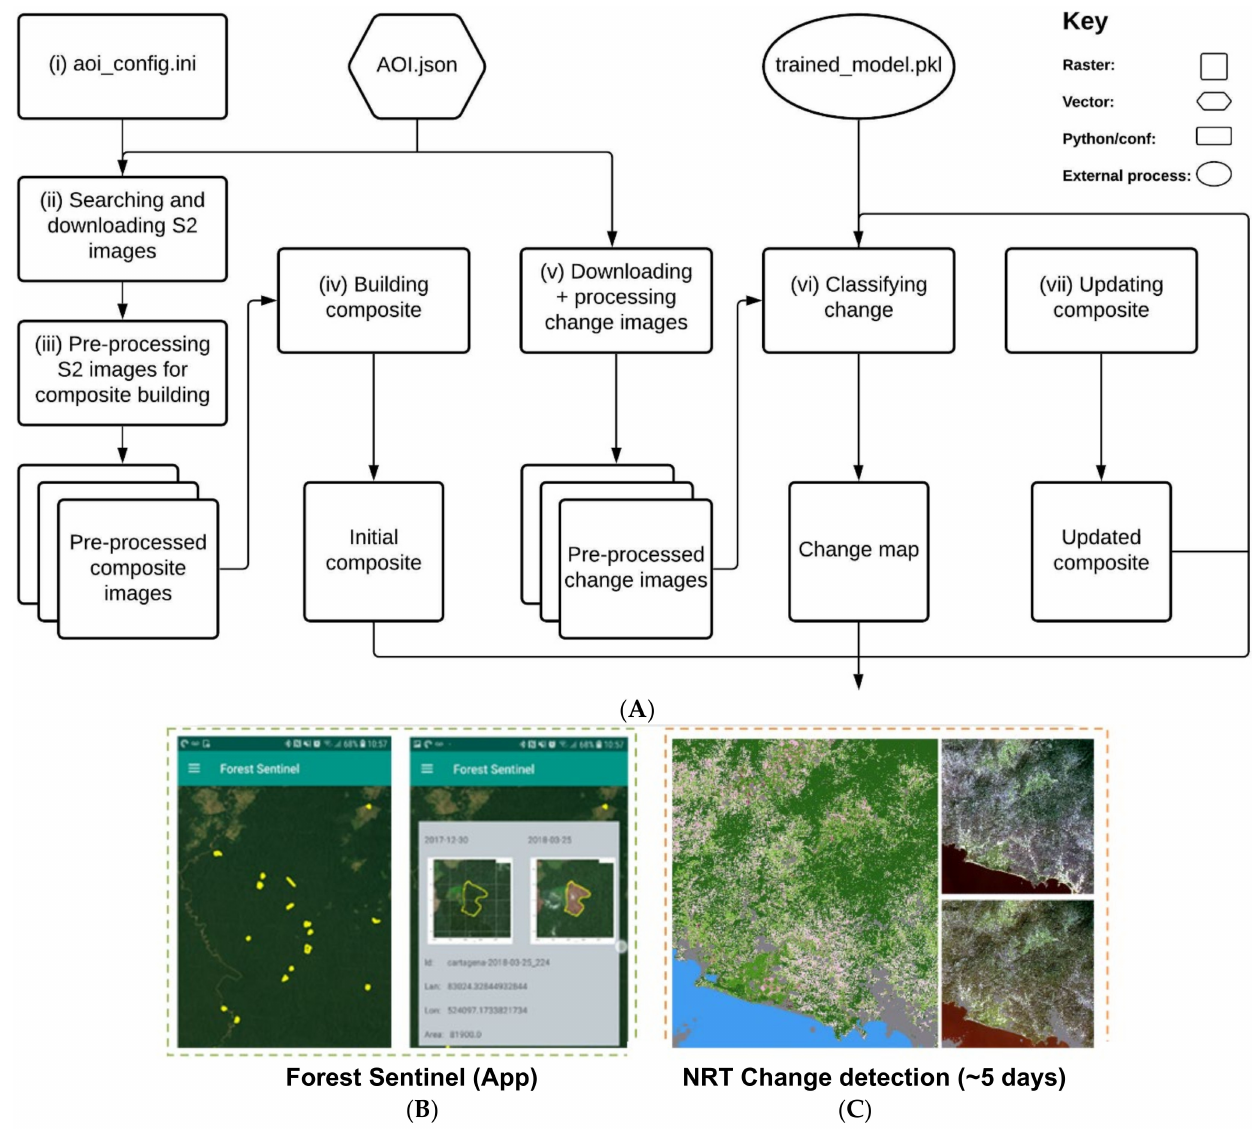
Figure 1. ( A ) A conceptual diagram of the proposed near real-time processing chain and outputs. S2 refers to the Sentinel-2 images. AOI refers to the area of interest or area of studio. The aoi_config.ini is the file containing all parameters for processing the Sentinel-2 image. The trained_model.pkl refers to any pre-trained machine-learning model. ( B ) An example of a deforestation alert in the Forest Sentinel App. ( C ) A quick look at the classification of